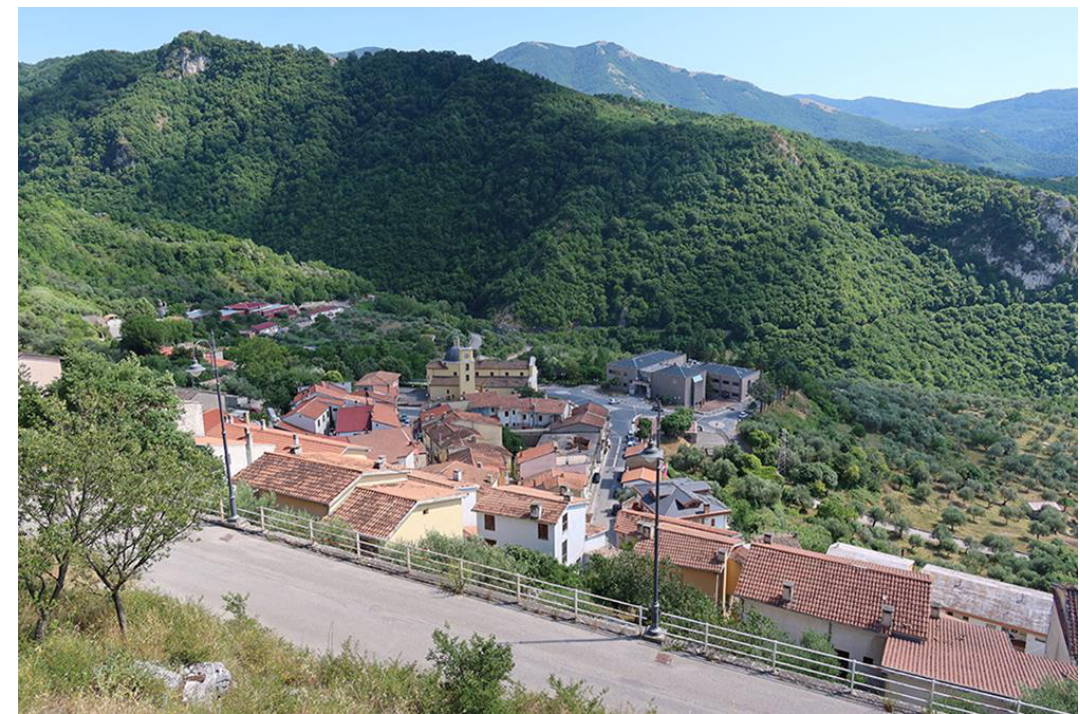
Figure 29. Santomenna: overview of the village completely rebuilt (photos by [35,36]).